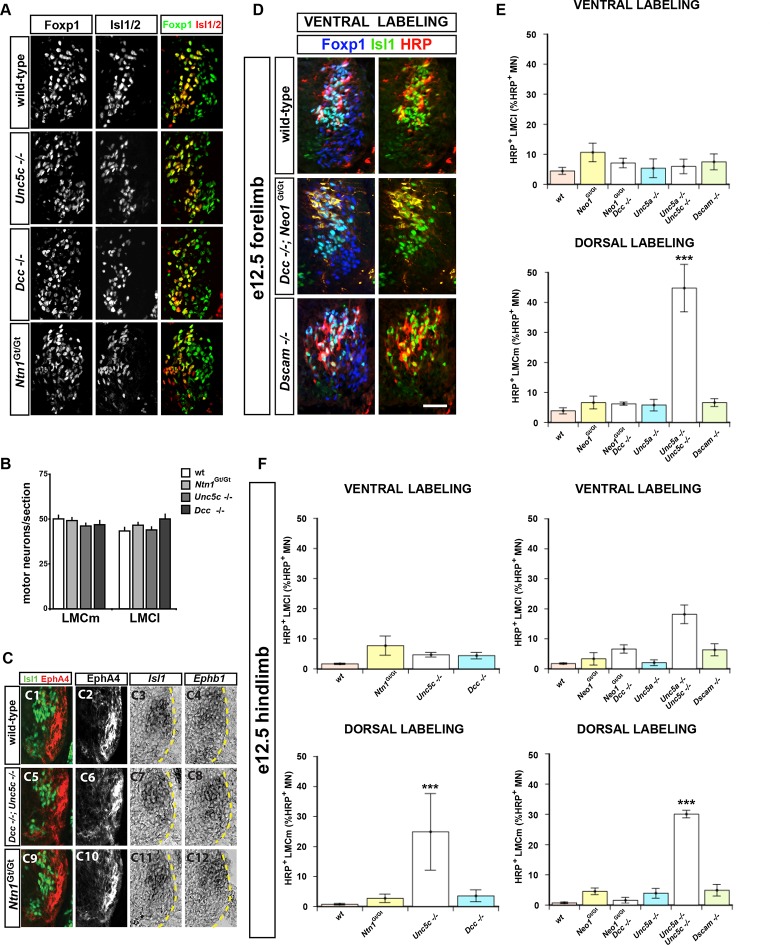
Normal specification of LMC neurons in Unc5c, Dcc, and Ntn1Gt mutants and summary of LMC axon trajectory analysis in mutant mice.(A–C) Normal specification of LMC neurons in Unc5c-/-, Dcc-/-, and Ntn1Gt/Gt mice. (A) The number of medial and lateral LMC neurons was determined in e13.5 cervical and lumbar spinal cord sections from different mutant mice immunostained for Isl1 and Foxp1. (B) Quantification of medial and lateral LMC neurons in wt, Unc5-/-, Dcc-/-, and Ntn1Gt/Gt mice. (C) Normal expression of EphB1 and EphA4 in Unc5c-/-, Dcc-/-, and Ntn1Gt/Gt mice. E13.5 lumbar spinal cord sections from different mice were immunostained for Isl1 and EphA4 (C1-2, C5-6, C9-10) or analyzed by in situ hybridization for Isl1 and Ephb1 mRNA in consecutive sections (C3-4, C7-8, C11-12). (D and E) Summary of analysis of lateral (ventral labeling) and medial (dorsal labeling) LMC trajectories by backfill experiments in mice forelimbs of Neo1Gt/Gt double Dcc-/-;Neo1Gt/Gt, Unc5a-/-, double Unc5a-/-; Unc5c-/-, and Dscam-/- mice. Only the proportion of HRP+ LMC expressing Isl1 in dorsally filled double Unc5a-/-; Unc5c-/- embryos is significantly different from that of wt embryos (p<0.001). Number of embryos quantified for ventral fill: n = 5 (wt), 4 (Neo1Gt/Gt), 3 (Dcc-/- and Neo1Gt/Gt), 4 (Unc5a-/-), 4 (Unc5c-/- and Unc5a-/-), 4 (Dscam-/-). Number of embryos quantified for dorsal fill: n = 3 (wt), 4, (Neo1Gt/Gt), 4 (Dcc-/-; Neo1Gt/Gt), 4 (Unc5a-/-), 3 (Unc5c-/-; Unc5a-/-), 3 (Dscam-/-). (F) Summary of analysis of lateral (ventral labeling) and medial (dorsal labeling) LMC trajectories by backfill experiments in e12.5 mice hindlimbs of different Netrin mutants as indicated. The proportions of HRP+ LMC expressing Isl1 in dorsally filled Unc5c-/-and Unc5a-/-; Unc5c-/- embryos are significantly different from that of wt embryos (p<0.001 for both groups). Number of embryos quantified for ventral fill: n = 7 (wt), 3, (Neo1Gt/Gt), 4 (Dcc-/-; Neo1Gt/Gt), 4 (Unc5a-/-), 3 (Unc5c-/-; Unc5a-/-), 4 (Dscam-/-). Number of embryos quantified for dorsal fill: 4 (wt), 4, (Neo1Gt/Gt), 3 (Dcc-/- and Neo1Gt/Gt), 4 (Unc5a-/-), 3 (Unc5c-/-; Unc5a-/-), 3 (Dscam-/-). HRP, horseradish peroxidase; LMC, lateral motor column; wt, wild-type; error bars = SD; *** = p<0.001; statistical significance computed using Student’s unpaired t test (B) or Fisher’s exact test on raw numbers (E, F); all values are mean ± SD. Quantification details in supplemental file 1C. Scale bars: (A) 50 μm; (C) 80 μm; (D) 40 μm.